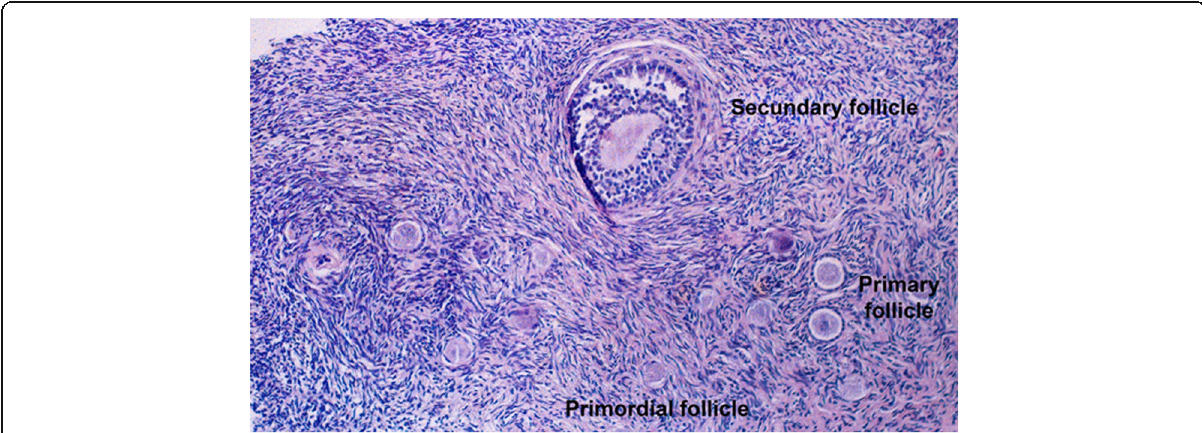
Fig. 2 Ovarian histology (hematoxylin/eosin staining, 100x)